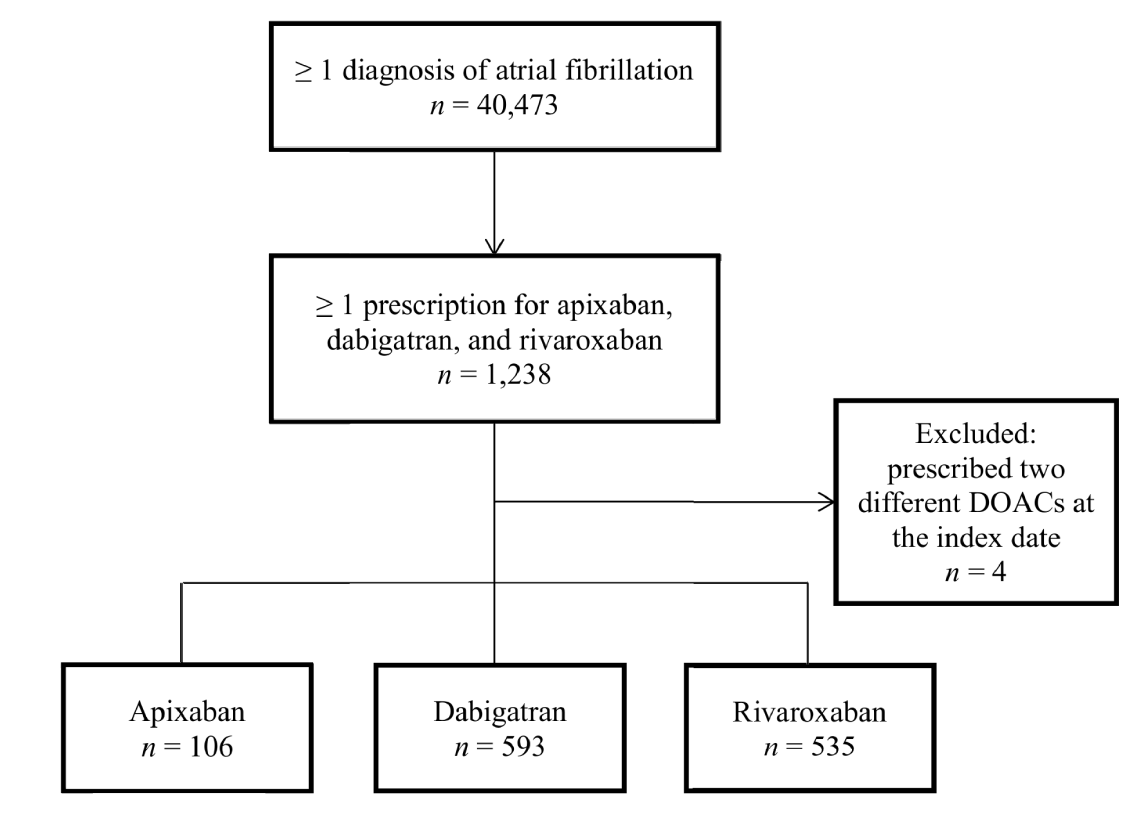
Fig 1. Flow chart of patient selection.